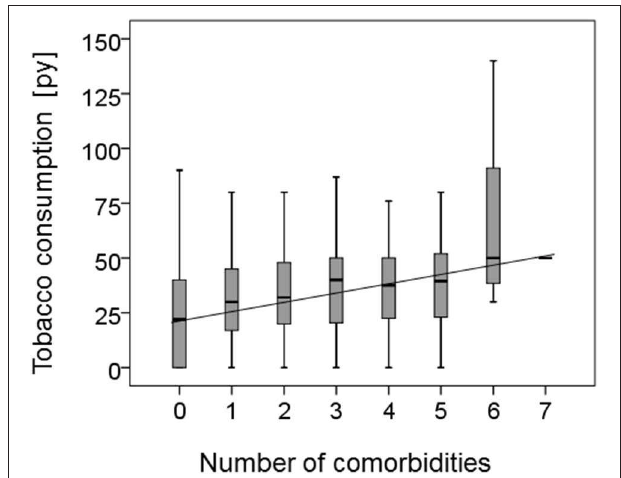
FIGURE 1 | Correlation of smoking habit and co-morbidity. The correlation between the reported number of co-morbidities of the HNSCC patients and their tobacco consumption in pack years (py) is shown as a boxplot. In addition the regression co-efficiency was calculated demonstrating a correlation ( r 2 = 0.031) and an overall significance calculated by one way ANOVA of p = 0.046 between tobacco consumption and increasing number of